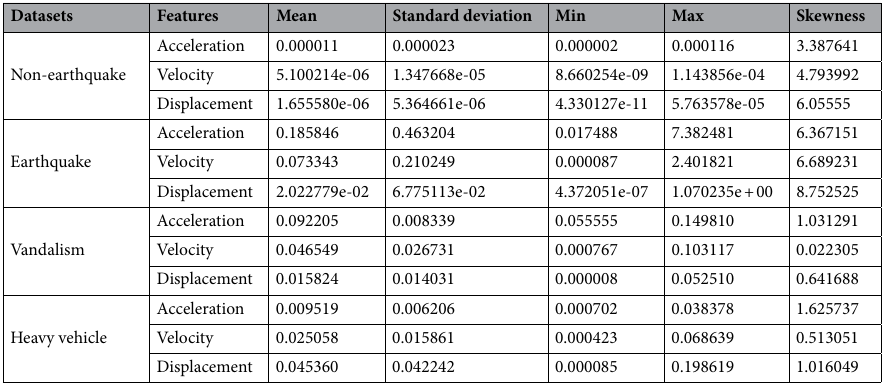
Table 1. Statistical analysis of